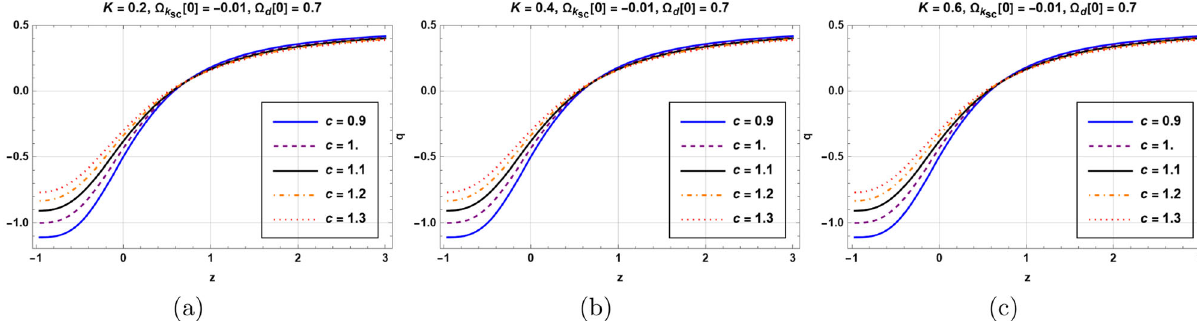
Fig. 6 The variation in the deceleration parameter q with redshift z for the open universe, in units when M 2 p = 1 , H 0 = 67 . 9. In order to be consistent with data, we now imposed (cid:2) d ( x = − ln ( 1 + z ) = 0 ) = (cid:2) d [ 0 ] = 0 . 7